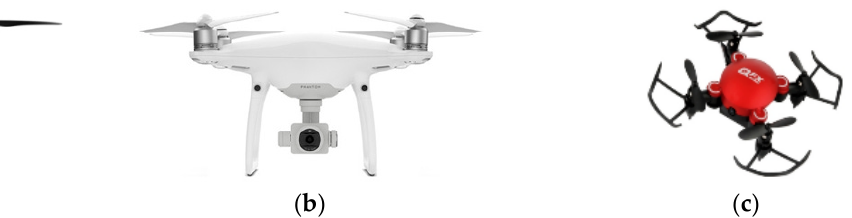
Figure 3. Examples of UAVs used to capture our dataset: ( a ) large UAV, ( b ) normal UAV, and ( c ) tiny UAV. Table 1. Attribute annotation in dataset.